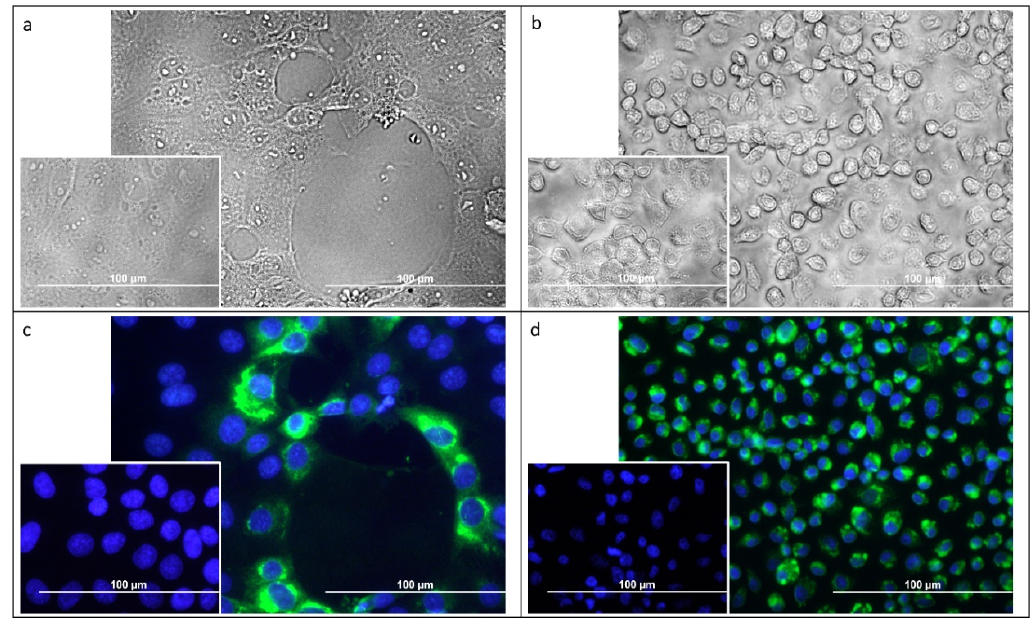
Figure 4. Mammalian, porcine kidney (PS) ( a , c ) and mosquito C6 / 36 cells ( b , d ) infected by the strains of Usutu virus isolated from dead blackbirds in this study. Infected cell cultures are presented in the large images and uninfected control cells in smaller images (3 days post-infection). Cytopathic effect was observed in infected PS cells ( a ) whereas no such changes were seen in C6 / 36 mosquito cells ( b ). Flaviviral E protein antigen was labeled using indirect immuno-fluorescence (green) in PS ( c ) and C6 / 36 cells ( d ). Cell nuclei were counterstained using DAPI (blue).